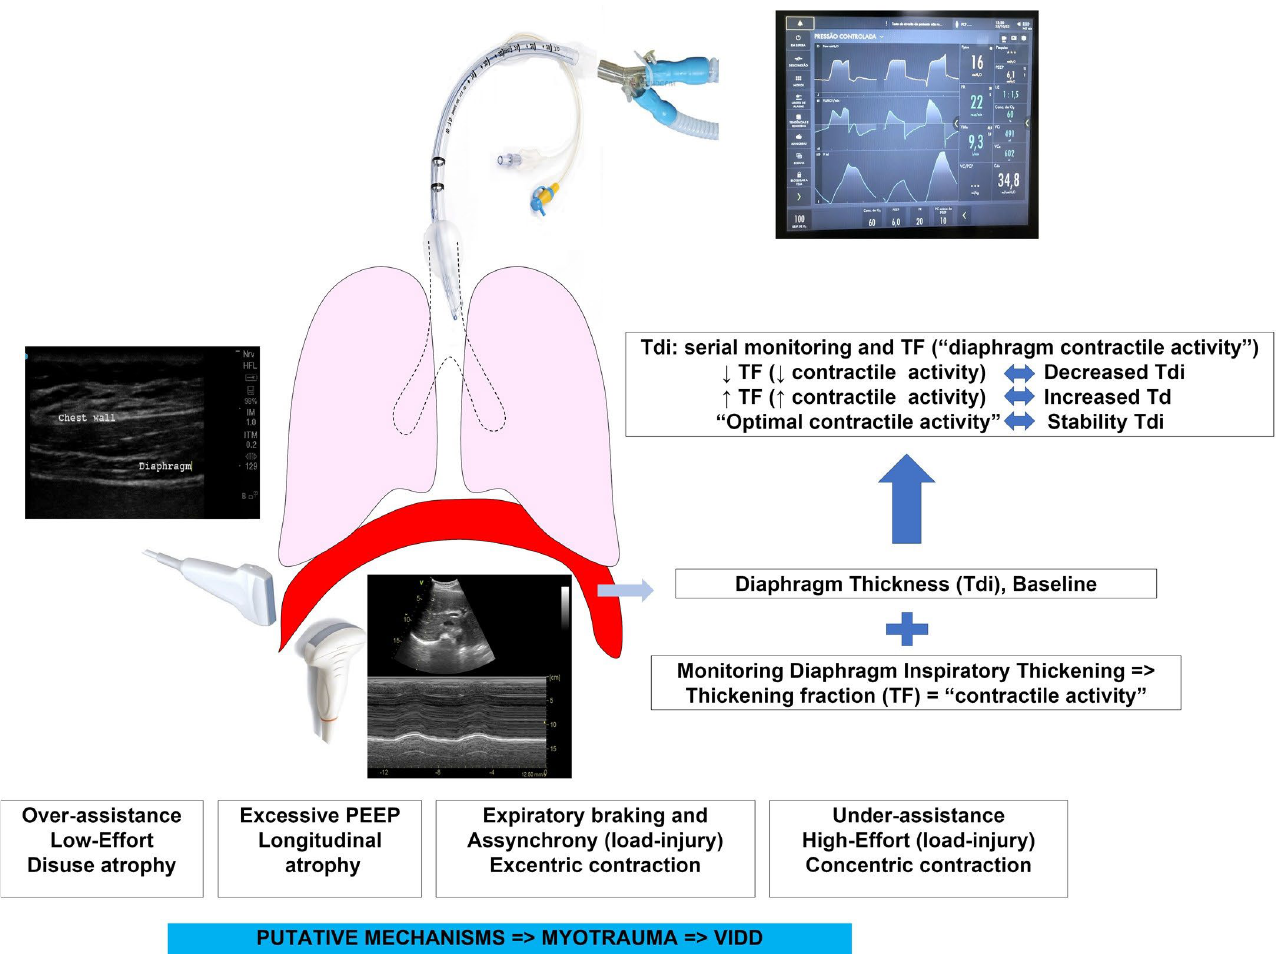
Figure 1. Possible rationale use of ultrasound to monitor diaphragm function in critically ill patients on mechanical ventilation (monitoring effort, assessing atrophy, assessing PVA). TF—thickening fraction; Tdi—diaphragm thickness; PEEP—positive end-expiratory pressure; VIDD—ventilator-induced diaphragmatic dysfunction.